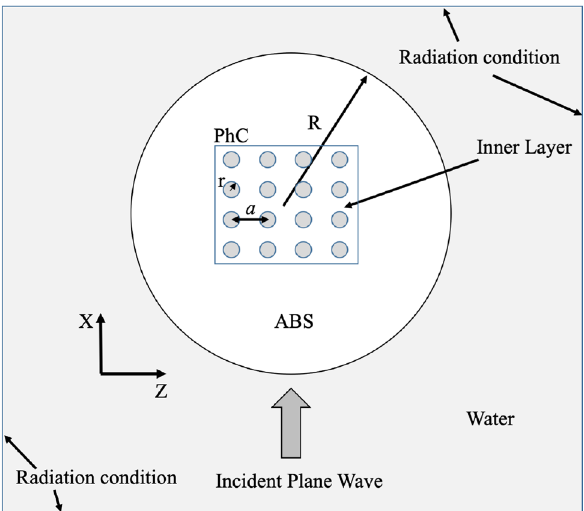
Figure 6. Scheme of the geometry and boundary conditions of the implemented FEM